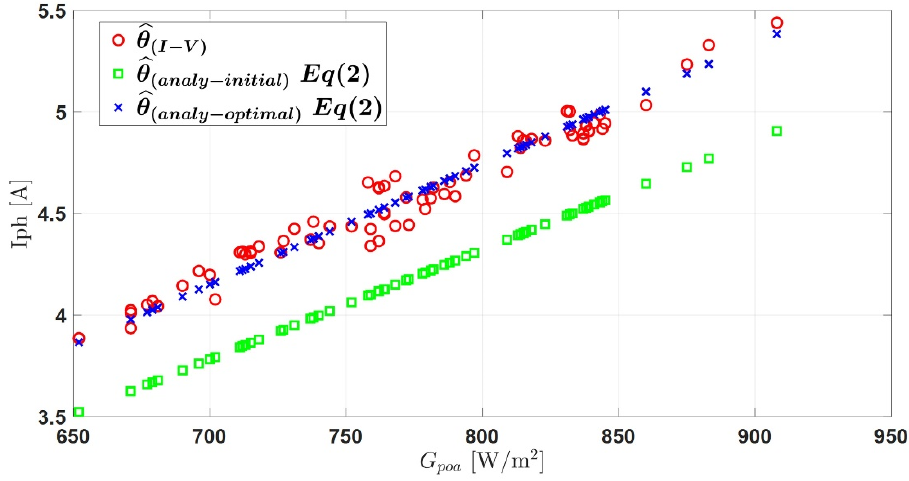
Figure 12. Evolution of the photocurrent with G poa for T pv = 56 ◦ Figure 12 . Evolution of the photocurrent with 𝐺 (cid:3043)(cid:3042)(cid:3028) for 𝑇 (cid:3043)(cid:3049) = 56°𝐶 .